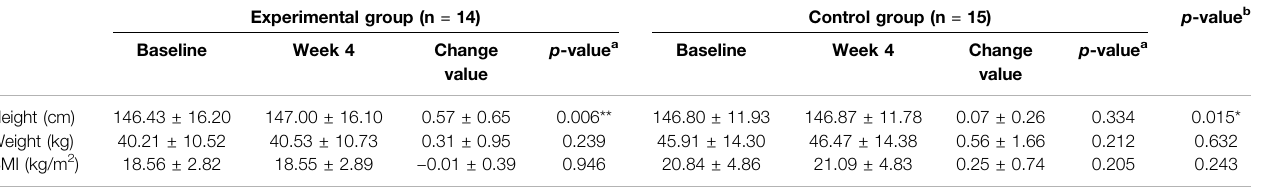
TABLE 5 | Changes in children ’ s height and